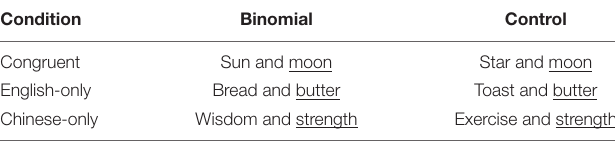
TABLE 2 | Example of stimulus materials for each condition. Condition Binomial Control Sun and